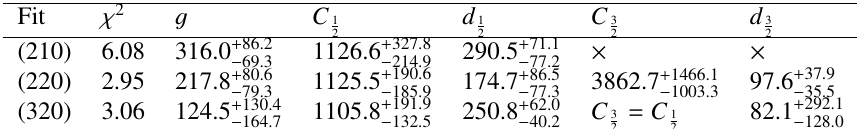
Figure 2. Reproduction of the experimental data by the di ff erent fits around the P cs (4459) resonance. The actual fitted area has a green shadow. The dot-dashed line curve in (210) results after imposing that = 0 at the mass and width values of Ref. [16]. Δ 1 / 2 Table 8. Fit parameters to data in the region of the P cs (4459).